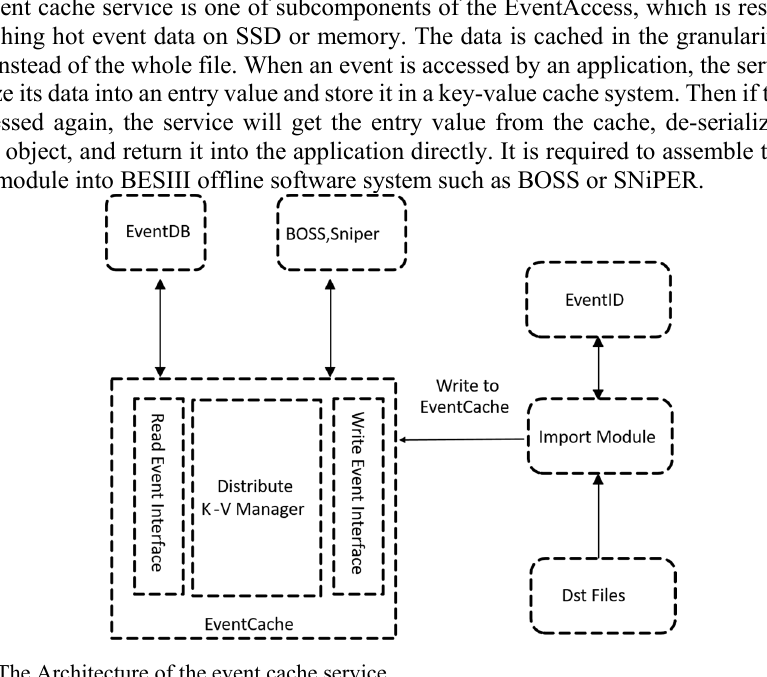
Fig. 4. The Architecture of the event cache Fig. 2. The comparison of storage capacity occupied by the EventIndexer and real data.